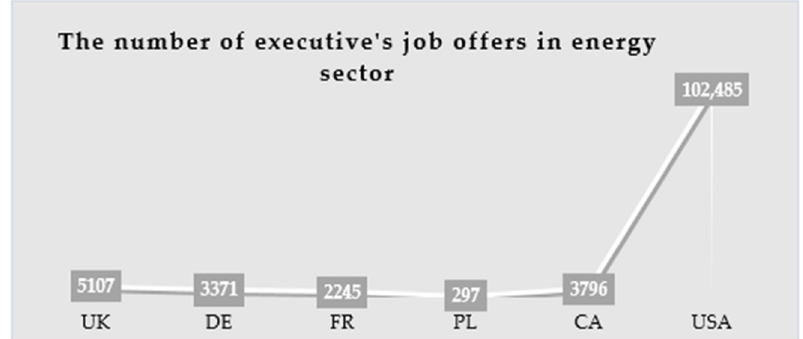
Figure 2. The number of job offers for executives in energy industry.